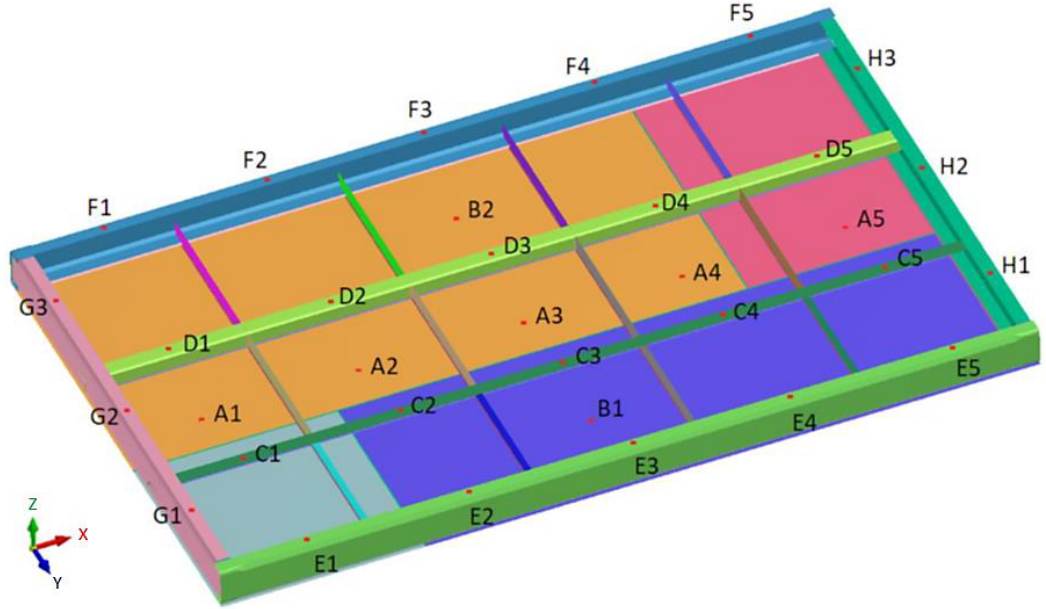
Figure 8. Distribution of selected measurement points where deformation values were determined in the numerical simulation of the furnace wall panel welding process.